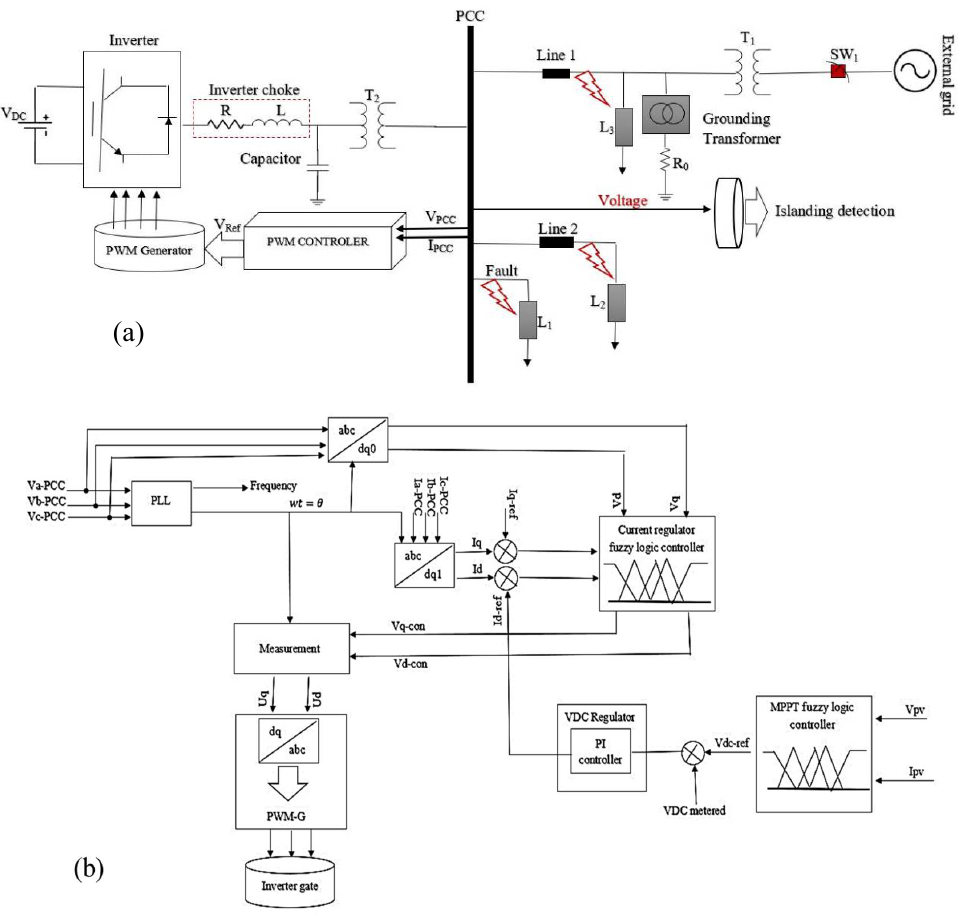
Figure 1. ( a ) The studied sample system. ( b ) The block diagram of the inverter control system.